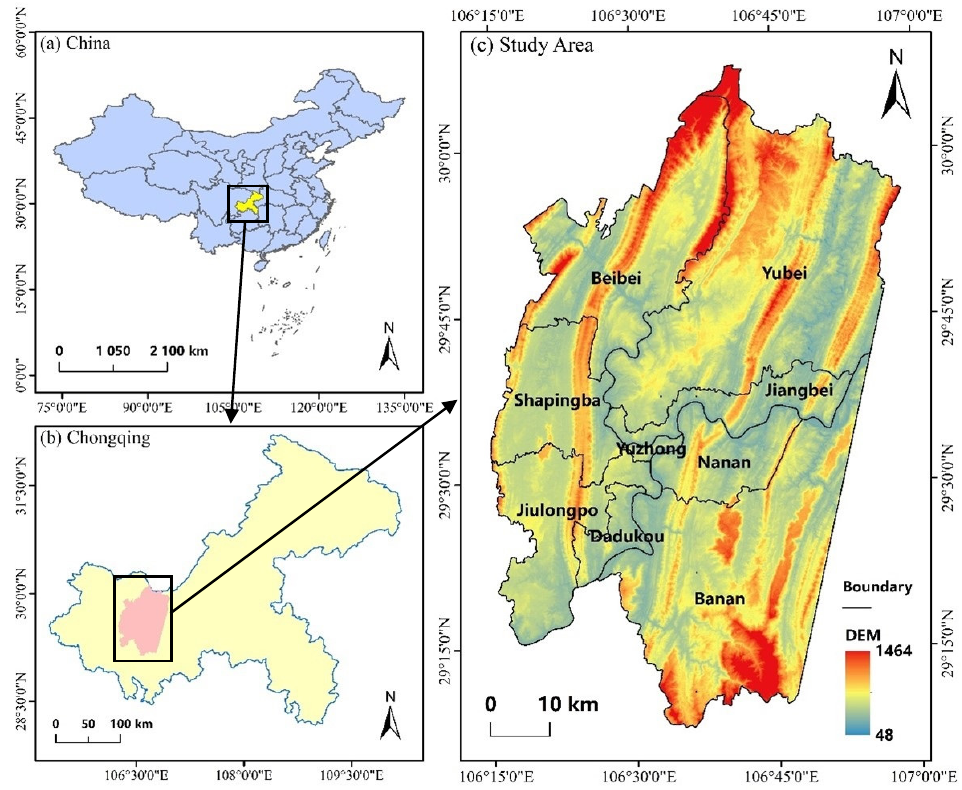
Figure 1. Study area of Chongqing. ( a ) Map of China, ( b ) map of Chongqing, ( c ) map of study area.